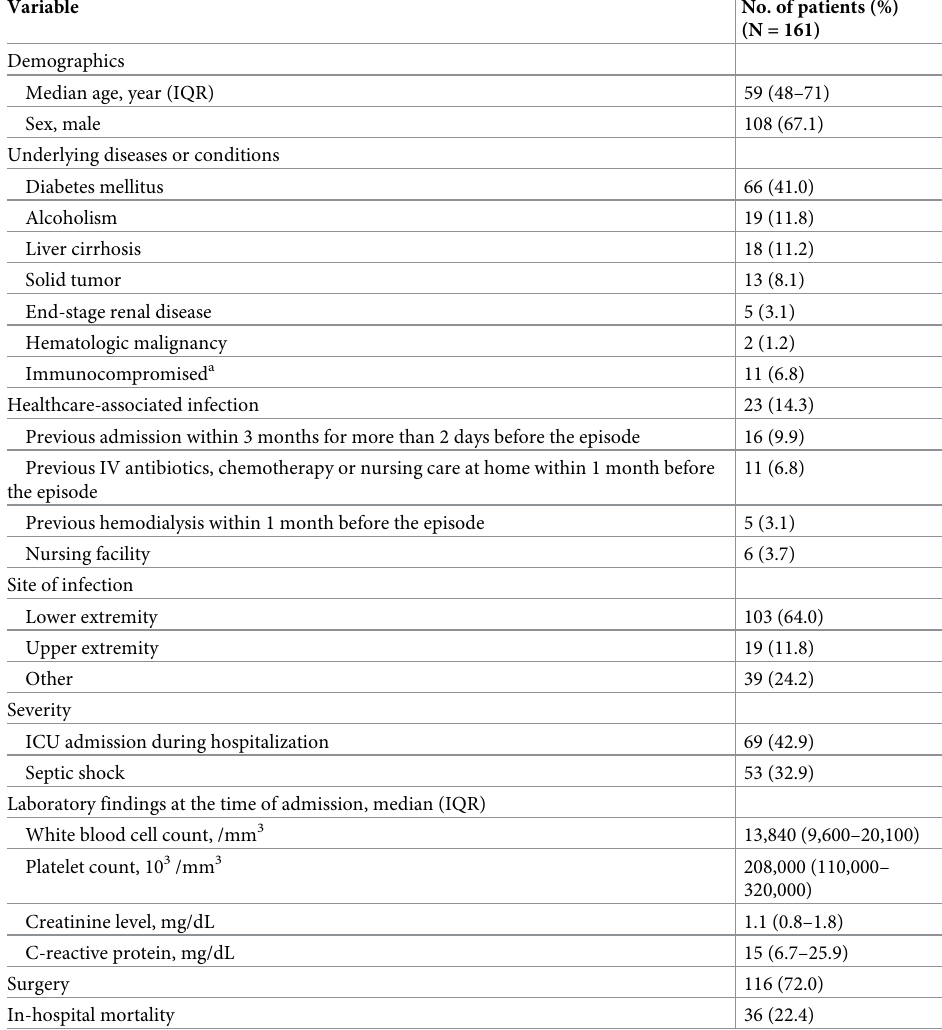
Table 1. Demographics, underlying disease/conditions, and clinical characteristics of patients with community- onset necrotizing